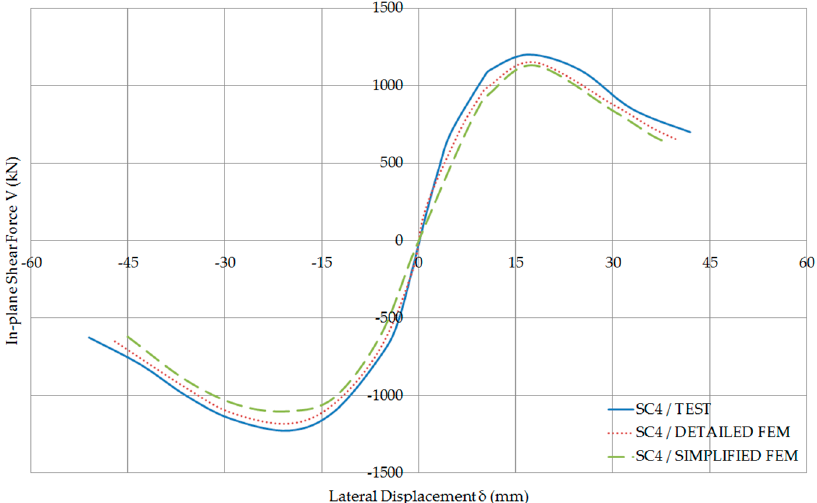
Figure 12. In-plane shear force—Lateral displacement Curves of SC4.